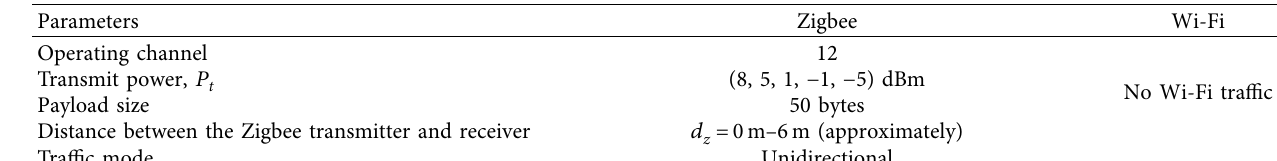
Figure 5: Throughput versus d z for a range of packet transmit timeouts. Table 4: Parameters for the experiments in Section 4.2.1.